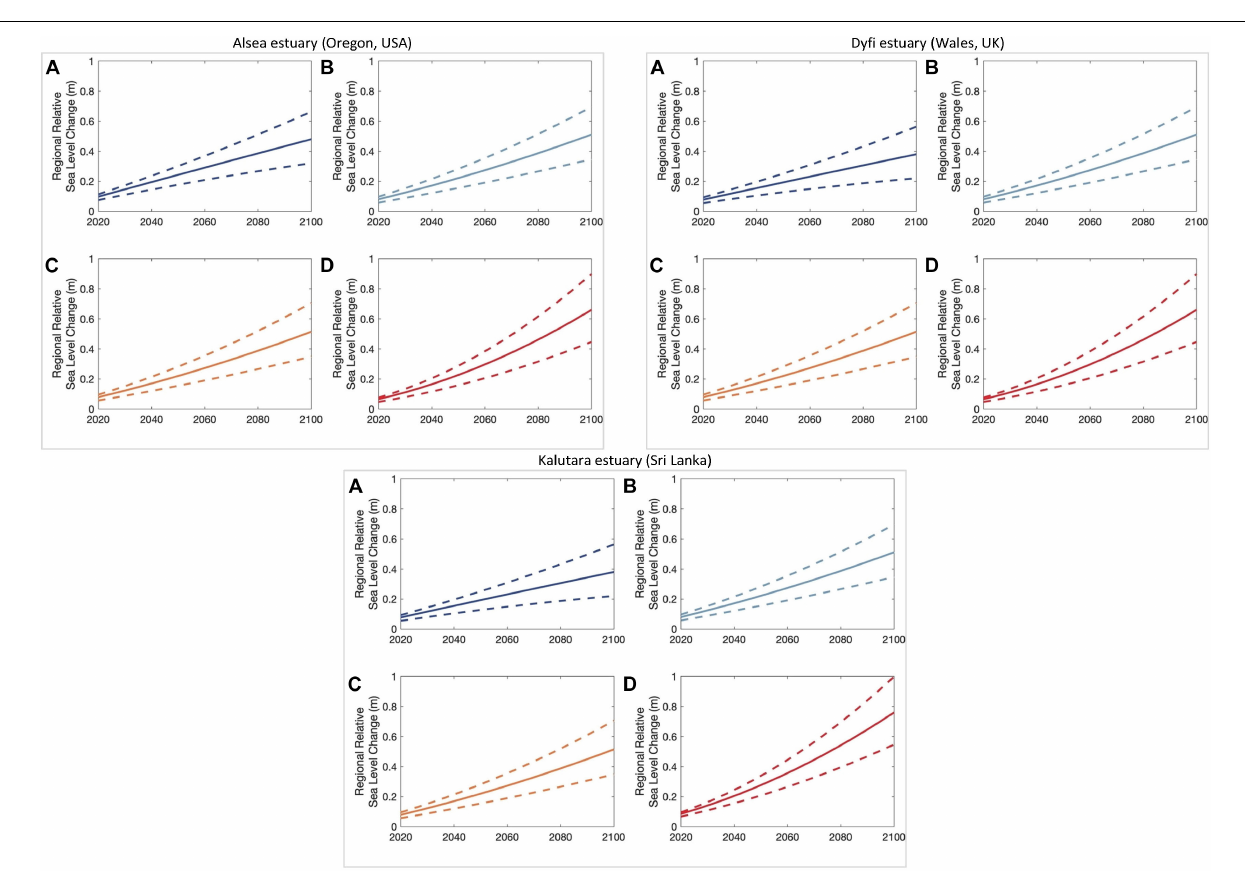
10 th and 90 th percentiles presented in Figure 6 ). During the first decadal period, there is very little uncertainty in the (cid:49) V T projections under all four RCPs, as evidenced by